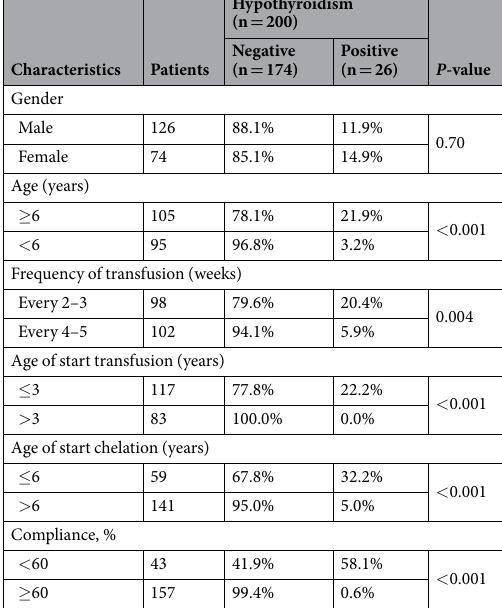
Characteristics